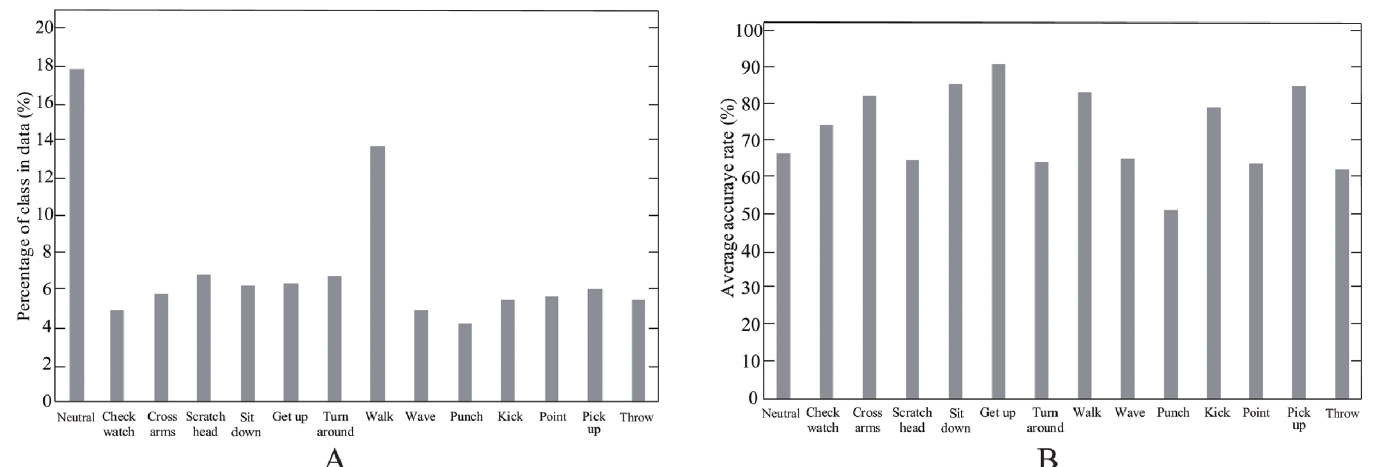
Fig 12. Percentage labels in dataset and accuracy rate of the proposed model. A: percentage of classes in IXMAS dataset segmented with t equaled to 50. B: accuracy of the proposed model for each class with t = 50.